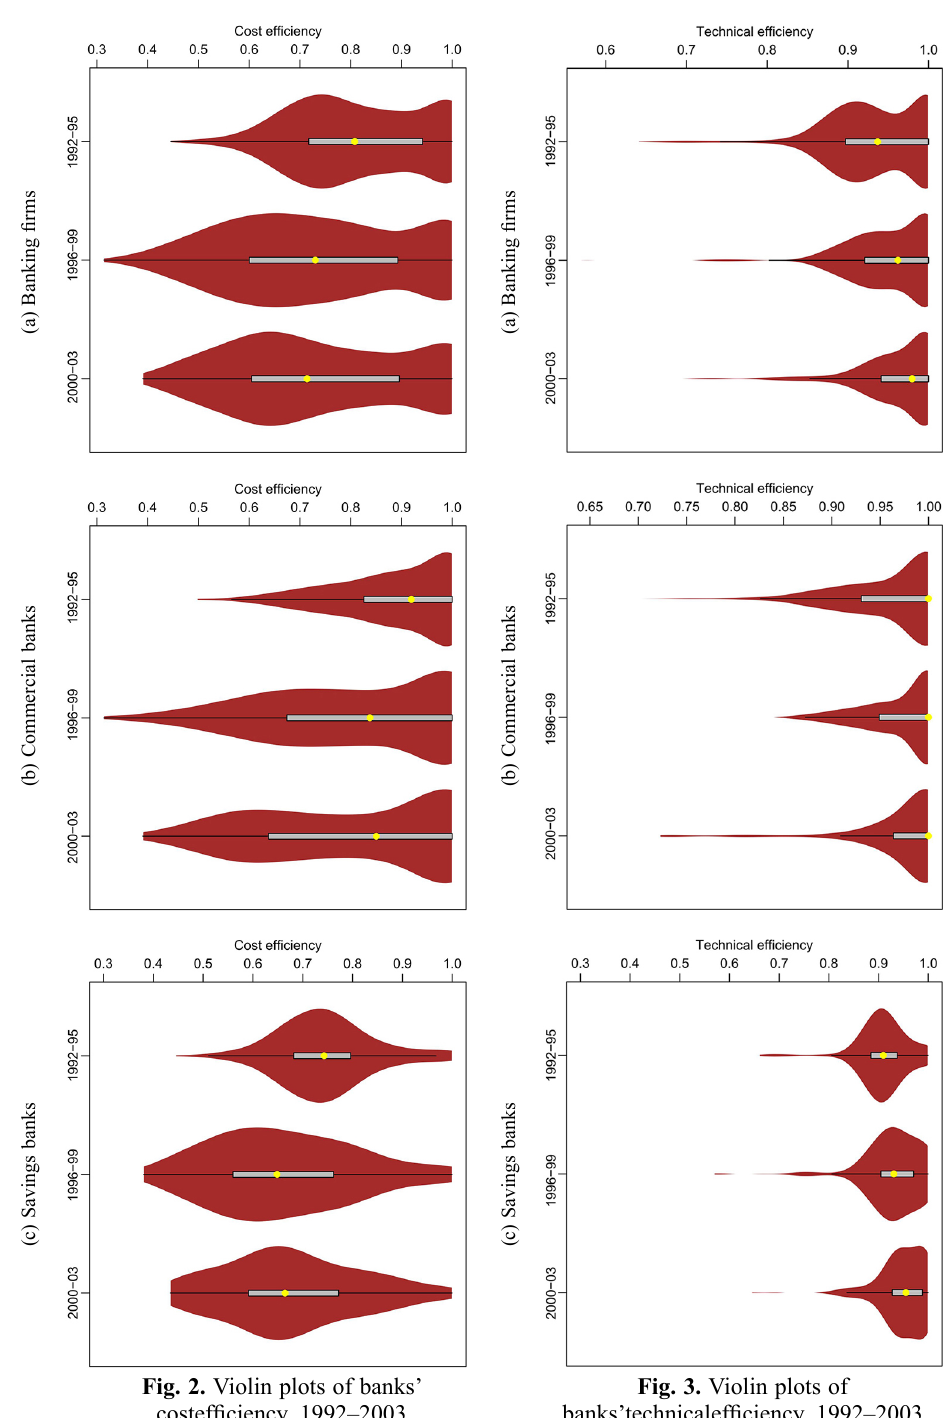
Fig. 2. Violin plots of banks’ Fig. 3. Violin plots